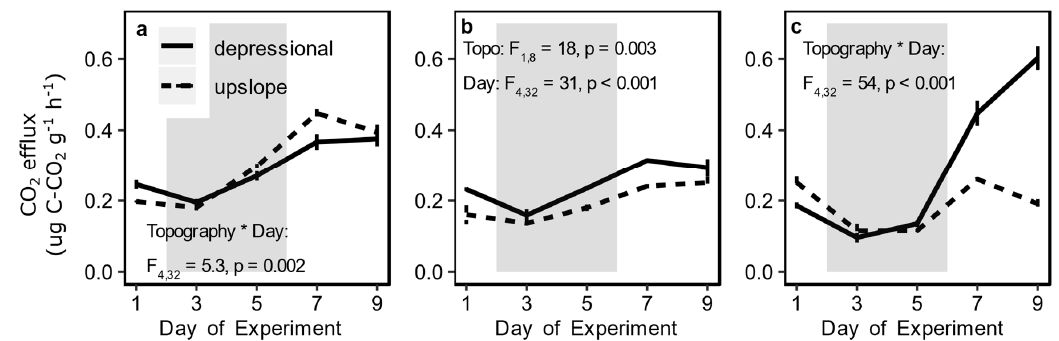
Figure 3. Soil CO 2 emissions (mean ± SE, n = 5) from unamended control soils from the South Farms ( a ), the Energy Farm ( b ), and Cardinal Road ( c ) over the course of the late season experiment. Solid lines represent emissions from depressional soils, and dotted lines represent emissions from upslope soils. Shaded areas represent when the soil cores were flooded. Results from ANOVAs run on linear mixed effects models are presented within each panel. Interaction effects are presented when significant interactions were detected. Otherwise, significant main effects are presented.